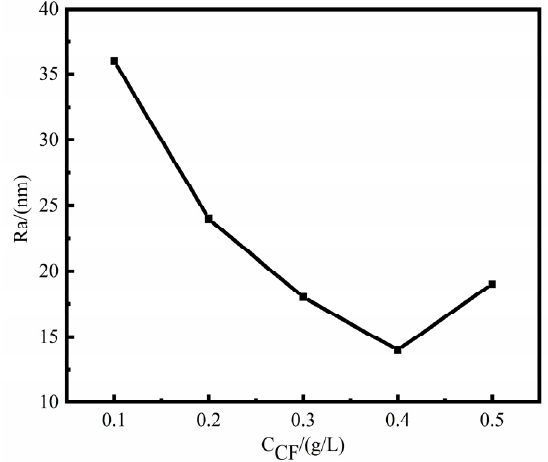
Figure 4. Effect of different concentrations of CF on surface roughness of Ni-W-CF composite coatings.